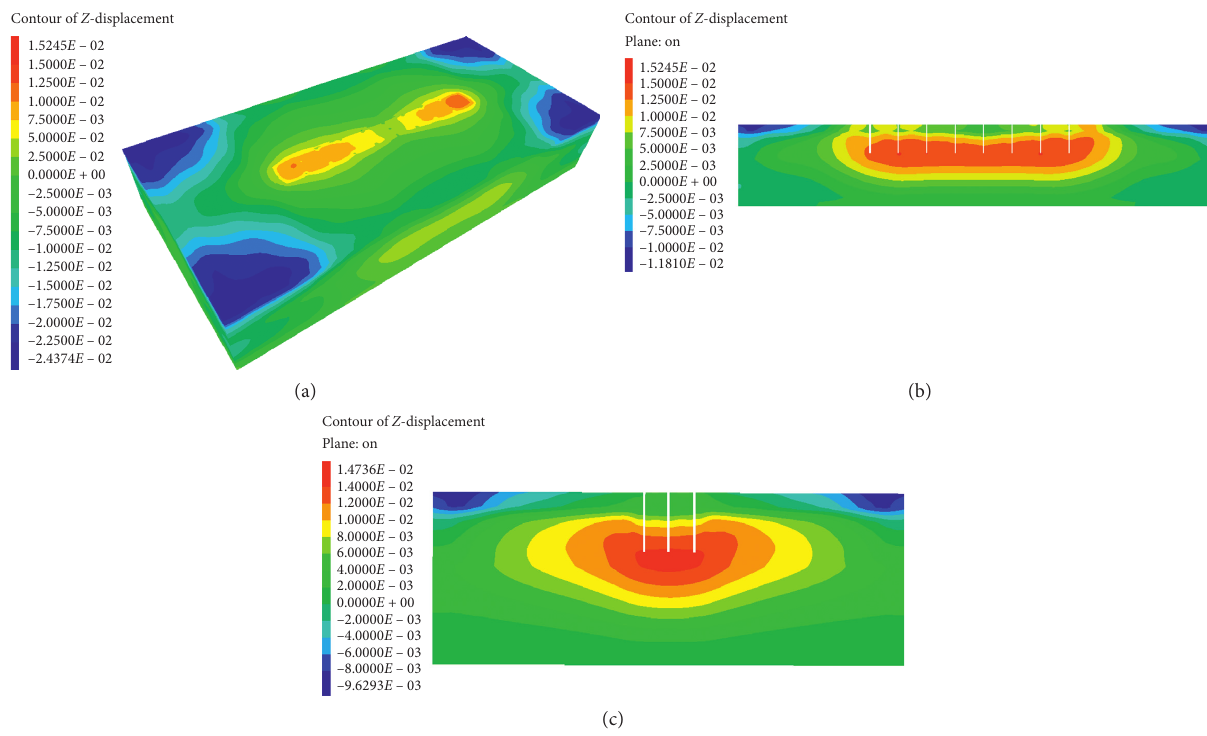
Figure 29: Group wells subsidence nephogram after the third drawdown (unit: m). (a) Three-dimensional diagram. (b) Cross section of the well midpoint. (c) Longitudinal section of the well midpoint.